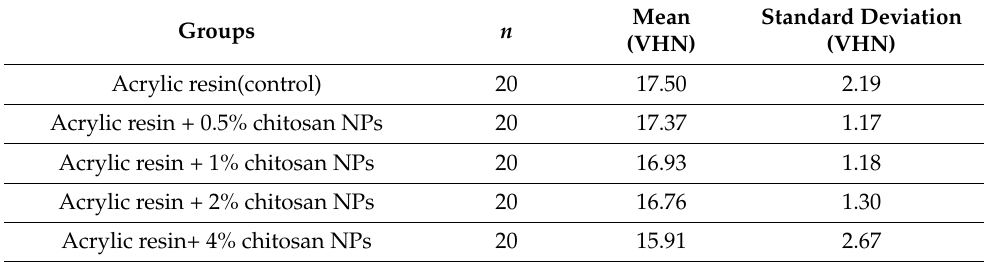
Table 5. Mean and standard deviation of the Microhardness in five different groups ( p > 0.05).